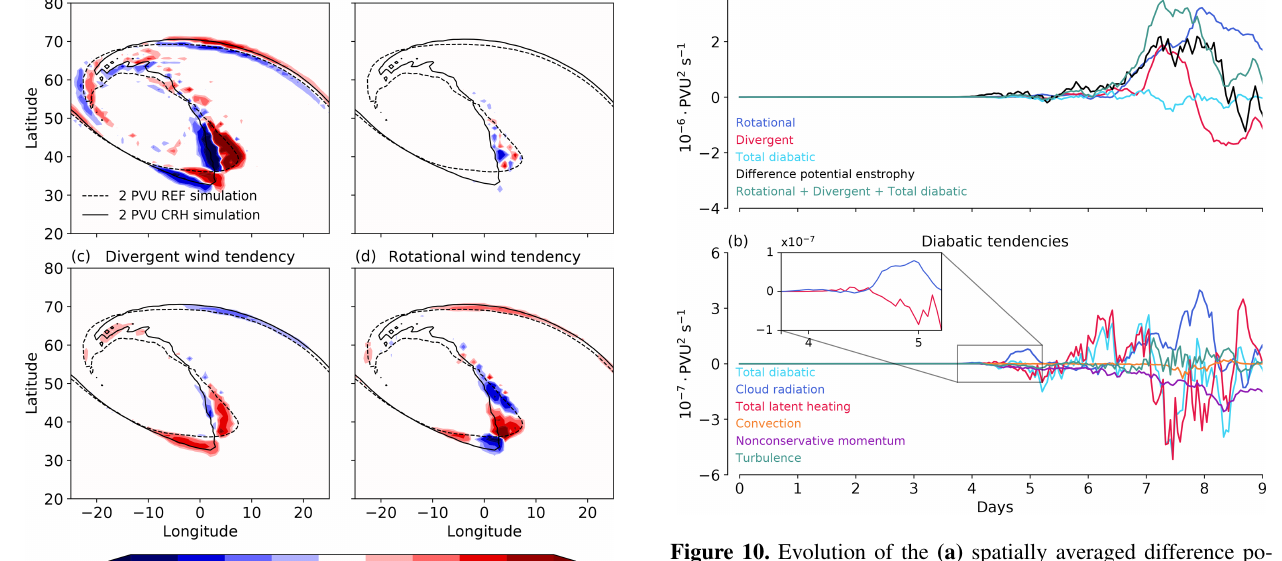
Figure 10. Evolution of the (a) spatially averaged difference po- tential enstrophy tendency and contributions from individual pro- cesses diagnosed from the r.h.s. of Eq. (8). The analysis is per- formed around the tropopause on the 326K isentrope. Panel (b) further decomposes the total diabatic (cyan line) contribution into the contributions from individual diabatic processes. Note the dif- ferent scales in